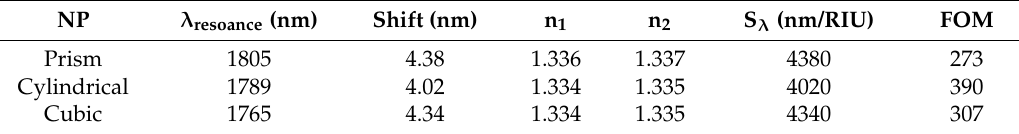
Table 1. Maximum sensitivity and FOM based on intensity and wavelength shift in different Au-G hybrid structures with prism, cylinder, and cubic NPs at specific changes in the refractive index. NP λ resoance (nm) Shift (nm) n 1 n 2 S λ (nm/RIU) FOM